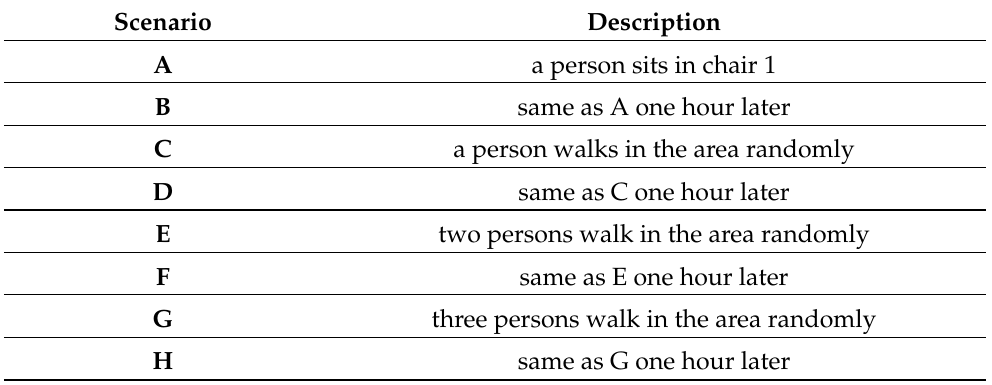
Table 2. Measurement scenarios for the tamper-free default